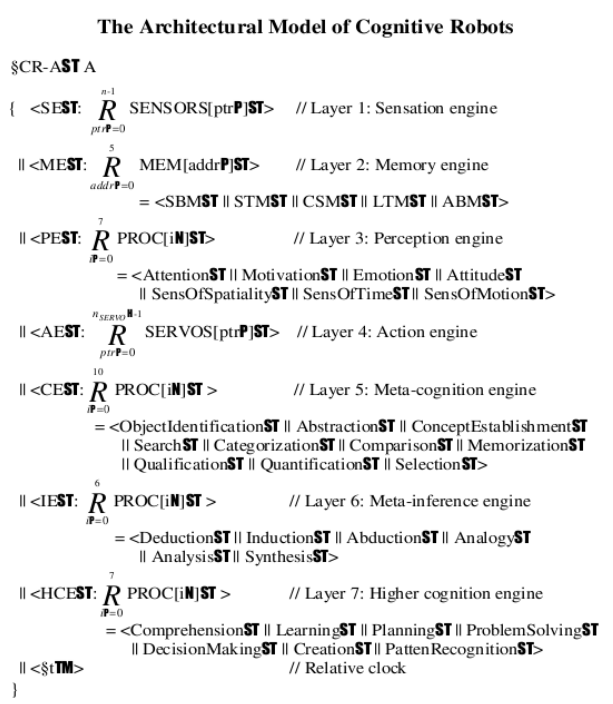
Figure 2. The architectural model of a cognitive